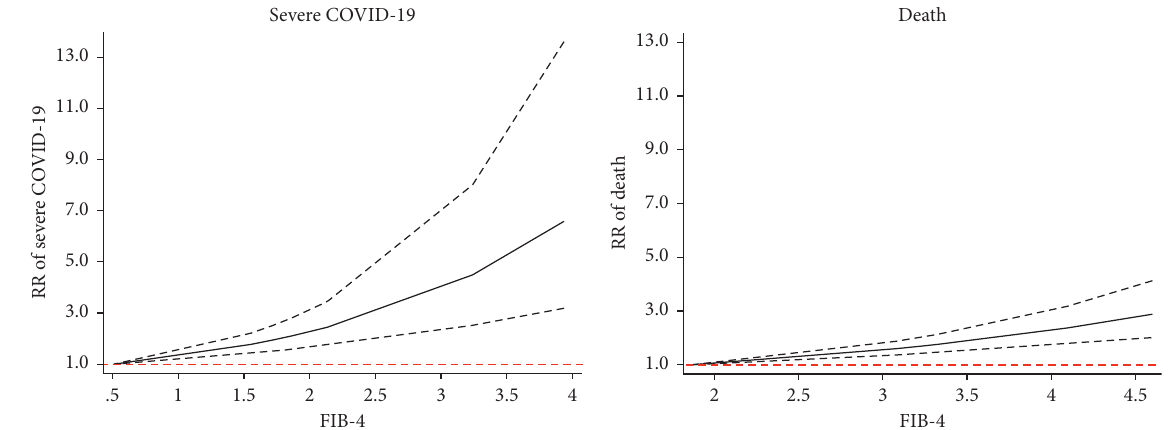
Figure 3: Nonlinear exposure-effect analysis between liver fibrosis scores and clinical outcomes in patients with COVID-19. (a) Hos- pitalization. (b) MV. (c) Severe COVID-19. (d) Death. The solid and dashed lines represent the estimated odd risk and the 95% confidence interval, respectively. Abbreviation: MV, mechanical